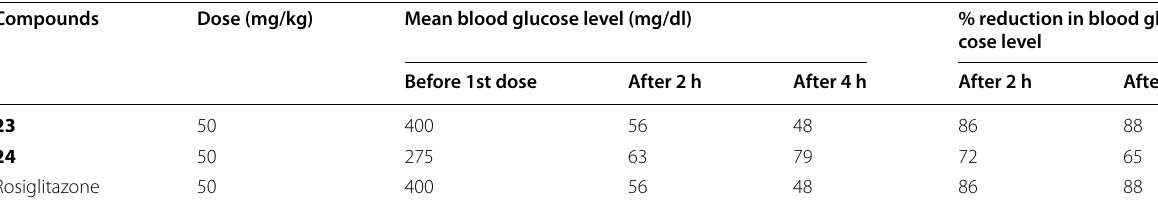
Table 9 Hypoglycemic activity of synthesized derivatives Compounds